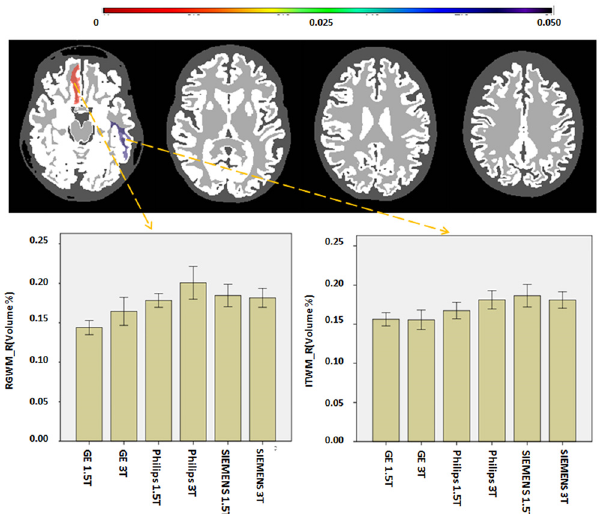
Fig 3. Regional volumes affected by the differences in protocol. The volumes are normalized by the “ total brain ” volume (parenchyma plus CSF). Two regions (left inferior temporal gyrus [ITWM_L] and the right rectus gyrus [RGWM_R] white matter) showed significantly smaller volumes on the GE